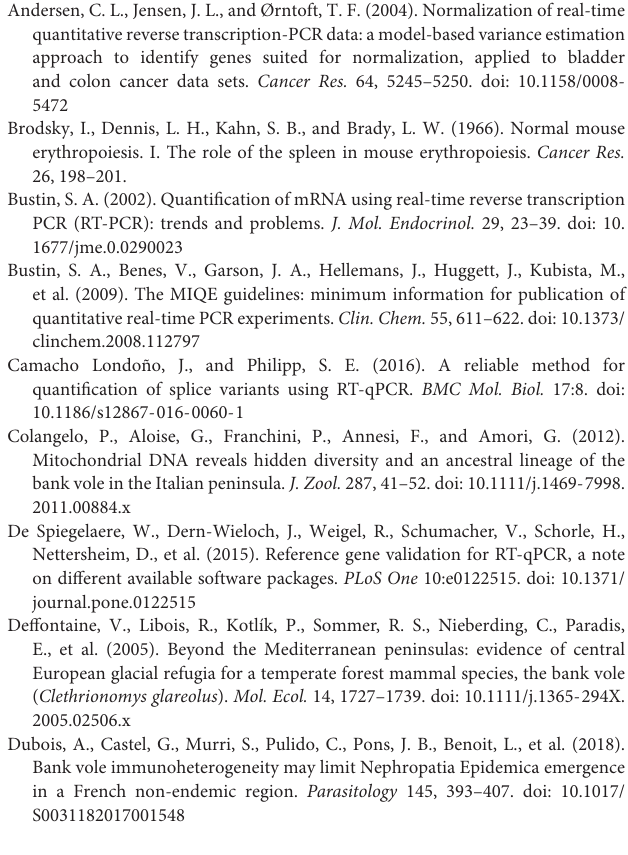
Supplementary Table 1 | The genes analyzed. Supplementary Table 2 | Geographical origin of the bank vole samples across Europe. Supplementary Table 3 | Primers used for RT-qPCR.